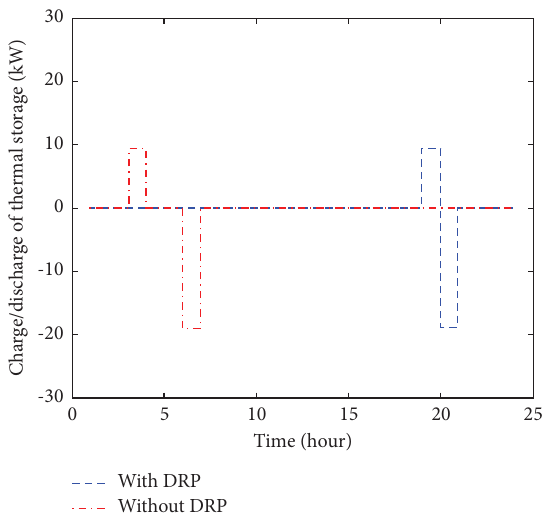
Figure 19: Charge and discharge of the thermal storage.